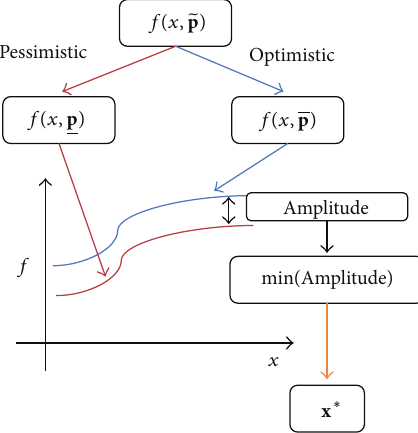
Figure 4: Flowchart of the amplitude minimization